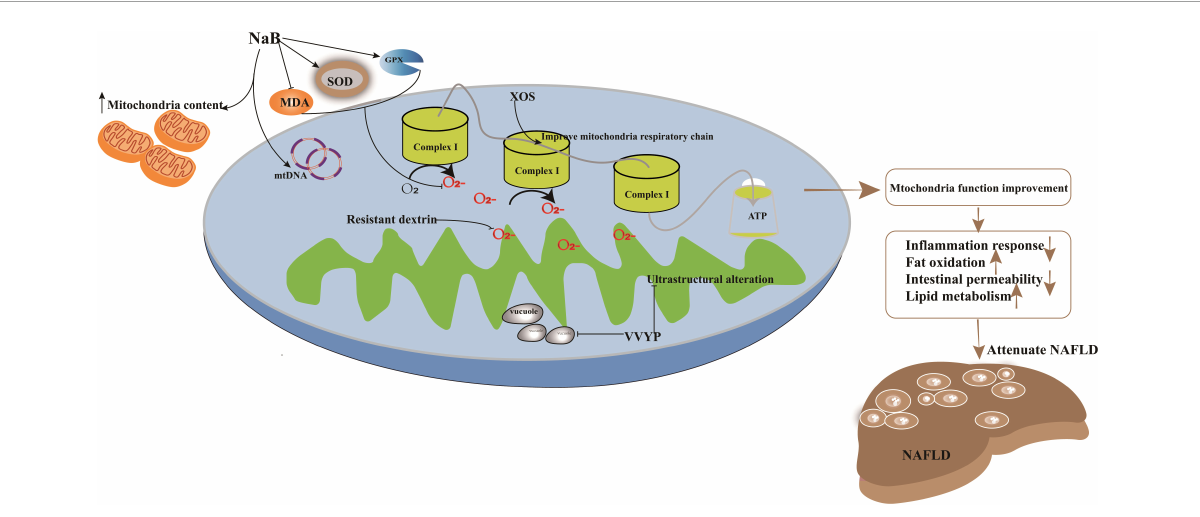
FIGURE2 Potential targets in improvement of mitochondria function induced by imbalanced gut microbiota to attenuate NAFLD. Treatment strategy target to mitochondria had been explored. For example, application with sodium butyrate (NaB) can significantly enhance mitochondrial DNA content in HepG2 cell and increase the membrane potential function and the content of mitochondria to ameliorate its impaired dysfunction. NaB can elevate the activity of SOD and GPX and deplete the levels of prooxidative NOX2, ROS, and MDA; XOS enhanced the level of complex I and promote oxidative phosphorylation to improve mitochondrial respiratory capacity and evaluate the production of ATP; VVYP can decrease fragmentation of vacuolate and swollen mitochondria and improve the lipid